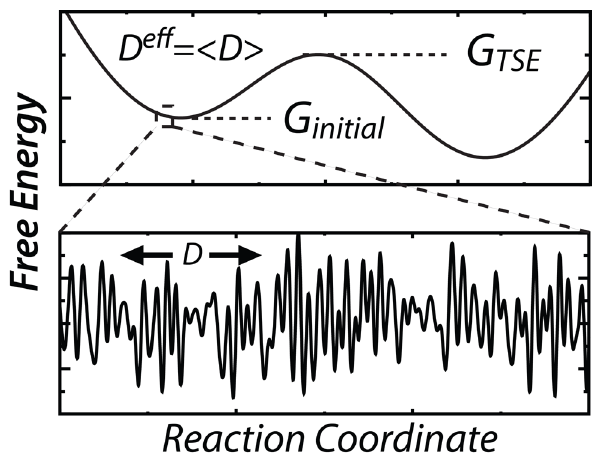
Figure 1. Energy landscapes. Short length-scale diffusion on a rough landscape D (bottom) may be averaged, yielding an effective diffusion D eff , which is obtained from simulation. Effective diffusion leads to barrier crossing attempts, where the probability of crossing is governed by the height of the long length-scale barrier ( G TSE { G initial ).